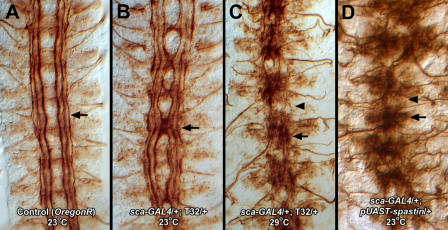
Neuronal Overexpression of Spastin Causes Midline Convergence of Embryonic CNS Axons(A) Anti-Fasciclin II (mAb 1D4) staining of filleted late stage 16 control embryos reveals three longitudinal axon bundles (arrow) on each side of the midline. Anterior is up.(B) In sca-GAL4/+; T32/+ embryos raised at room temperature, overexpression of Spastin in neurons causes the ladder to constrict toward the midline (e.g., arrow).(C) Increased Spastin expression at 29 °C causes collapse of the CNS onto the midline (arrow). Longitudinal axon tracts are thin or absent (arrowhead).(D) A phenotype similar to that in (C) is produced by sca-GAL4-driven expression of the UAS-spastin cDNA insertion at 23 °C. Arrow and arrowhead indicate same as in (C).